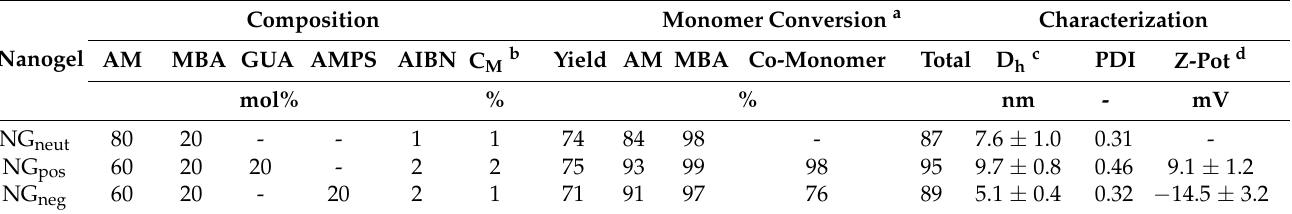
Table 1. Chemical composition, monomer conversions and characterization of nanogels with neutral (NG neut ), positive (NG pos ), or negative (NG neg ) surface charge. Monomer conversion was estimated via 1 H-NMR.